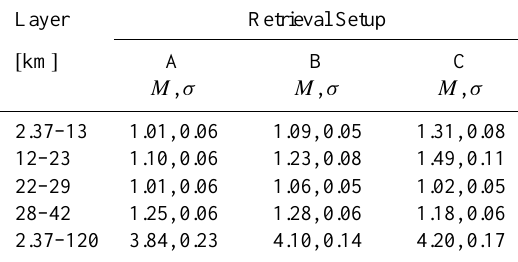
Table 2. Mean ( M ) and standard deviation ( σ ) of the DOFS time series of the retrieved ozone obtained from the Iza˜na IFS 120/5HR for all setups. These values are shown for each layer